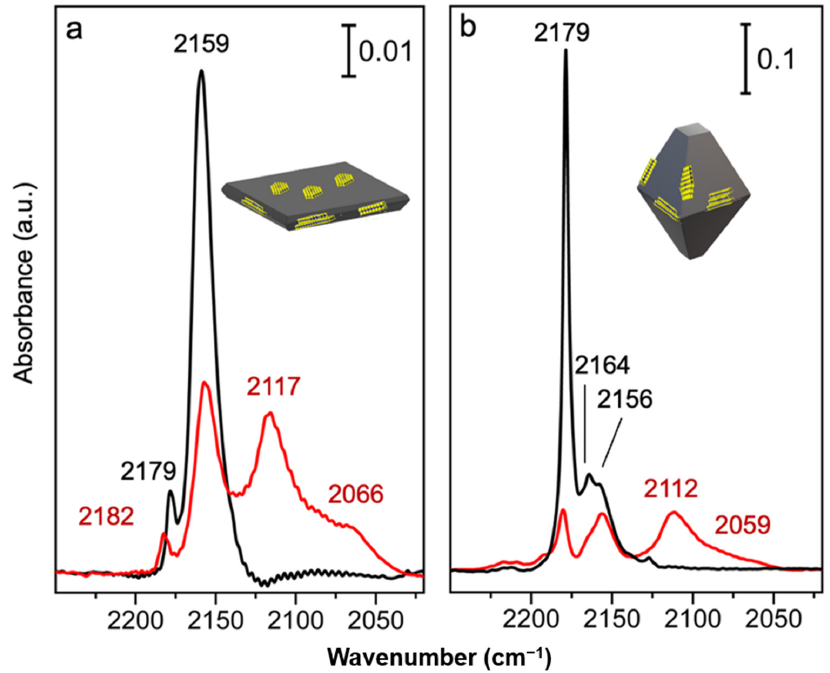
Figure 8. FTIR spectra of CO at 77 K at maximum coverage (40 Torr) adsorbed on the surface of: ( a ) TiO 2 n-sh (black line) and MoS 2 /TiO 2 n-sh (red line); ( b ) TiO 2 bipy (black line) and MoS 2 /TiO 2 bipy (red line).